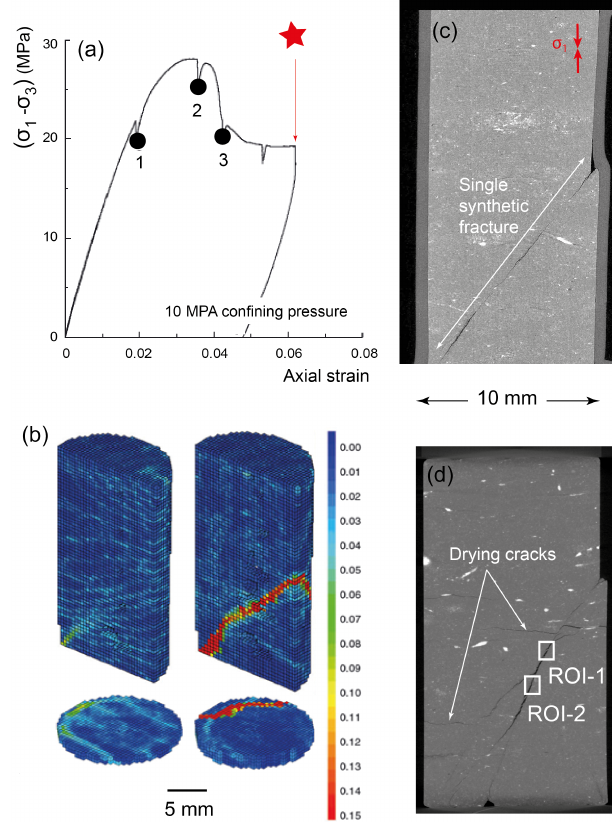
Figure 3. Results of deformation test done on sample COX-10MPa. (a) Deviator stress vs. axial strain response. The red star indicates the state of sample when BIB–SEM microstructural analyses are done. (b) Incremental maximum shear strain fields for deforma- tion increments 1–2 and 2–3 indicated in (a) interpreted after DIC. (c) Shows the X-ray radiography of the sample taken directly at the end of the deformation test, whereas (d) shows the X-ray radiog- raphy of the same sample but taken about 10 years after the end of the deformation: drying cracks developed following the bedding, and the aperture of the single shear fracture became larger. (d) Also indicates that two ROI were analysed, both around the single syn- thetic shear fracture. In (c) and (d) the bedding is perpendicular to the principal stress σ 1 indicated in (c) . Performed according to Lenoir et al. (2007).